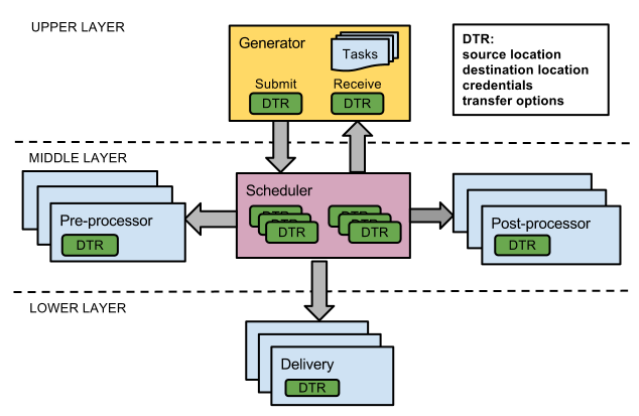
Figure 1: ARC Data Transfer Reloaded (DTR)